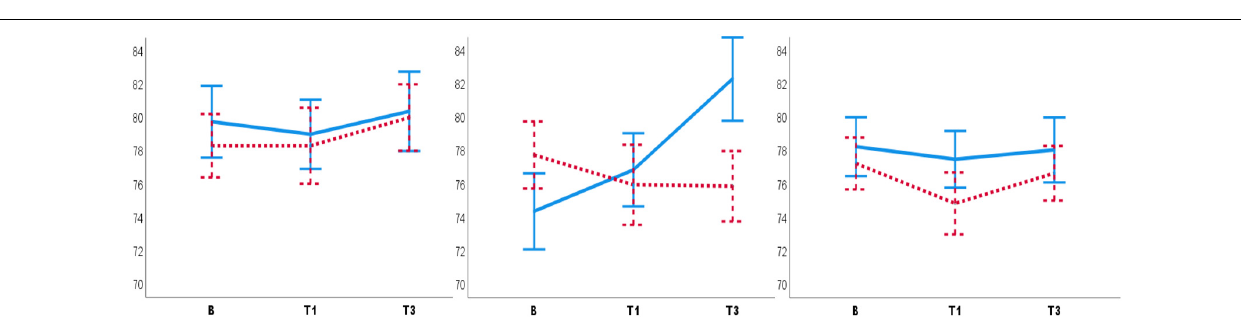
FIGURE 3 | Diastolic blood pressure recorded by the male (left panel) , the female (middle panel) and both male and female experimenters (right panel) . Female experimenters (middle panel) recorded lower DBP in PC T3 as compared to NHC T3. B, baseline. T1, pre-test. T3, post-test. Blue lines: NHC. Red dashed lines: PC. Error bars: ± 1 SE